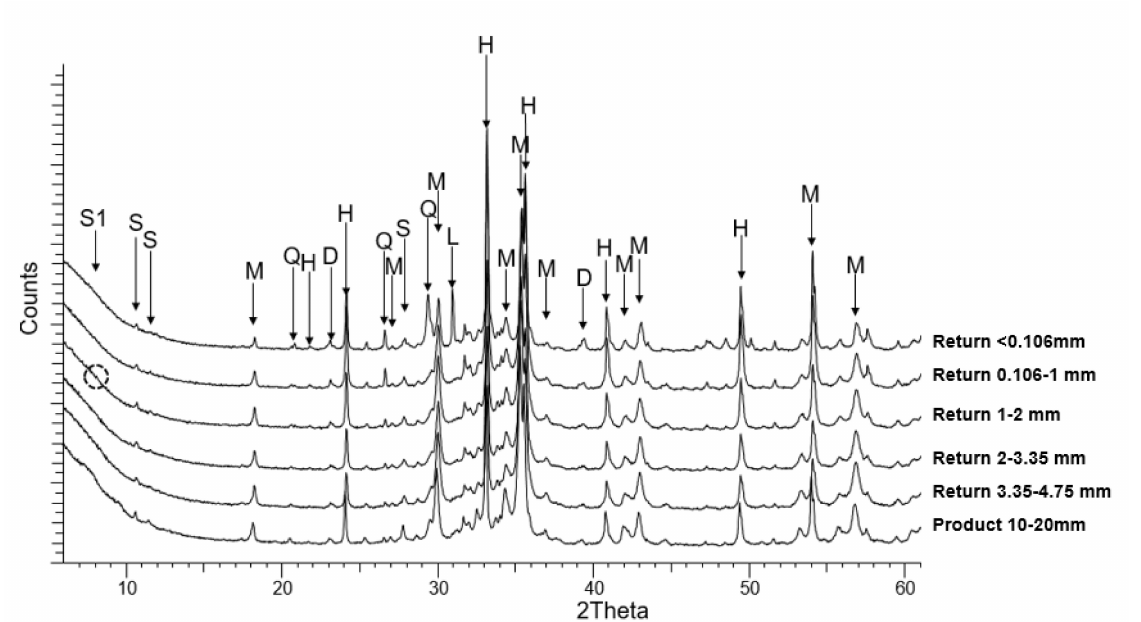
Figure 1. XRD pattern of sinter product and return samples reported by Chen et al. [27] (Cu K α , 40kv), S = SFCA solid solution, H = hematite; M = magnetite; Q = quartz; D = dicalcium-silicate C 2 S; L =